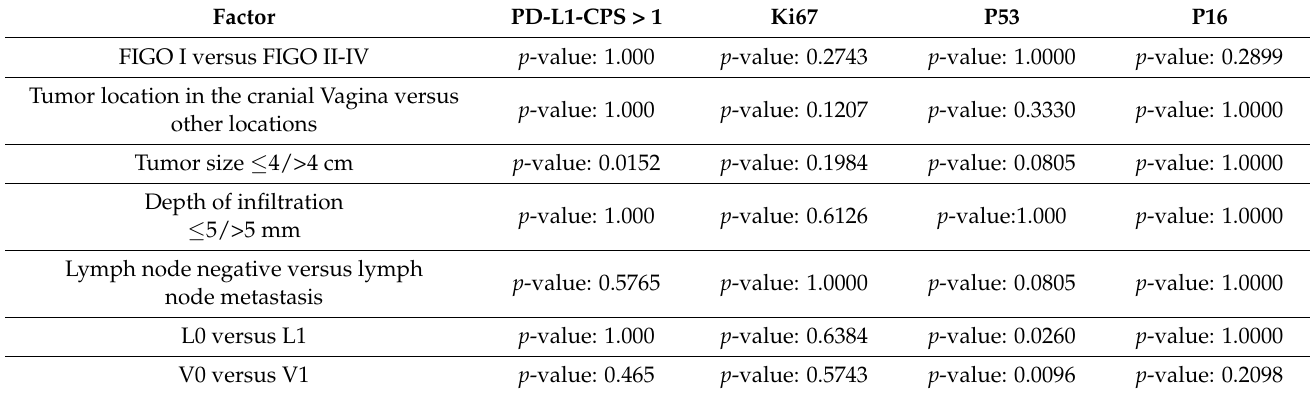
Table 4. Correlation of clinicopathological factors with immunohistochemistry. Factor PD-L1-CPS > 1 Ki67 P53 P16 FIGO I versus FIGO